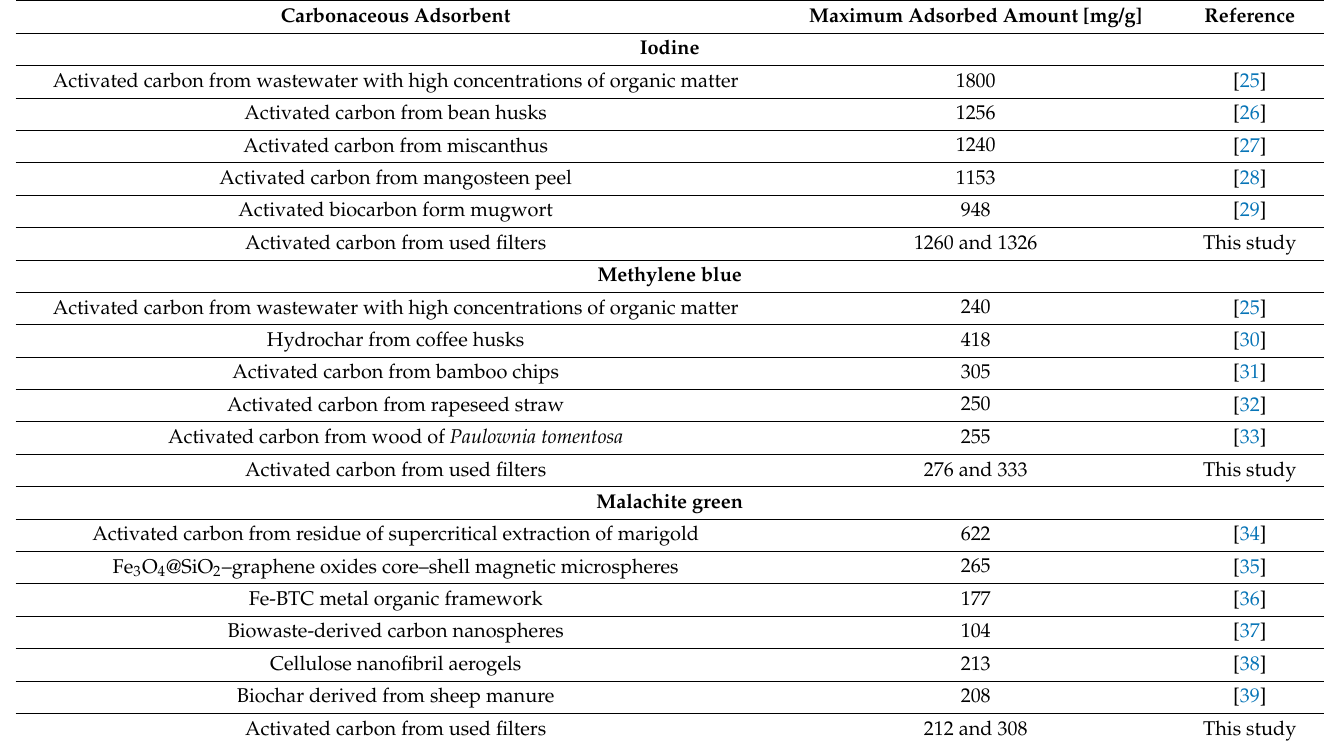
Table 5. Adsorption capacities towards iodine, methylene blue, and malachite green for various carbonaceous